Question: Name the type of graph shown.
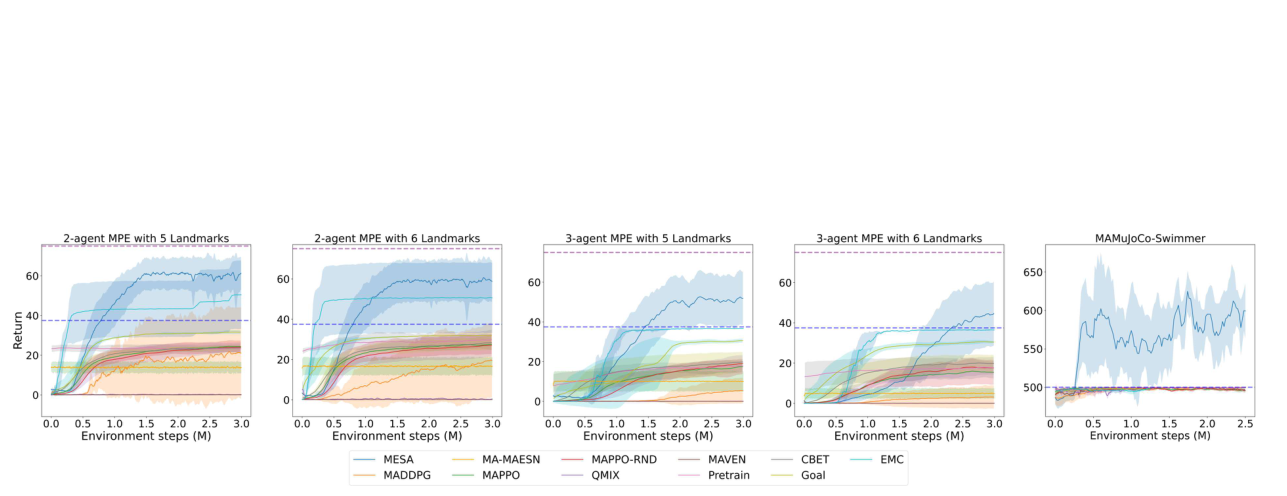
Answer: line